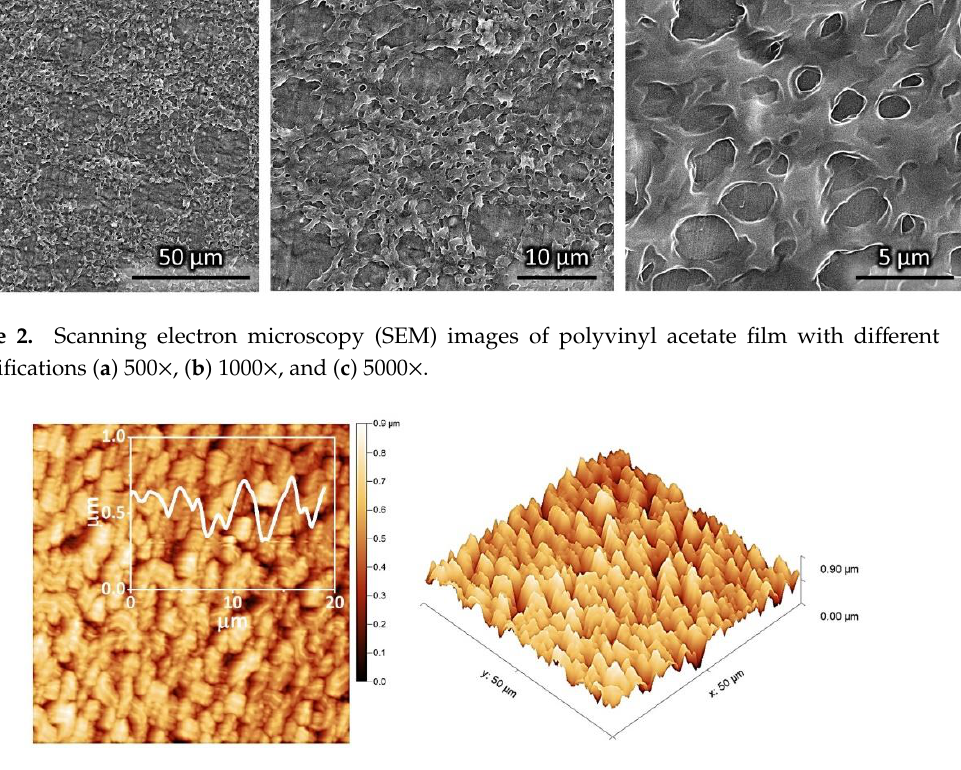
Figure 3. Atomic force microscopy (AFM) topography of deposited polyvinyl acetate (PVAc) film on quartz crystal microbalance (QCM) electrode (area of 50 µm × 50 µm).